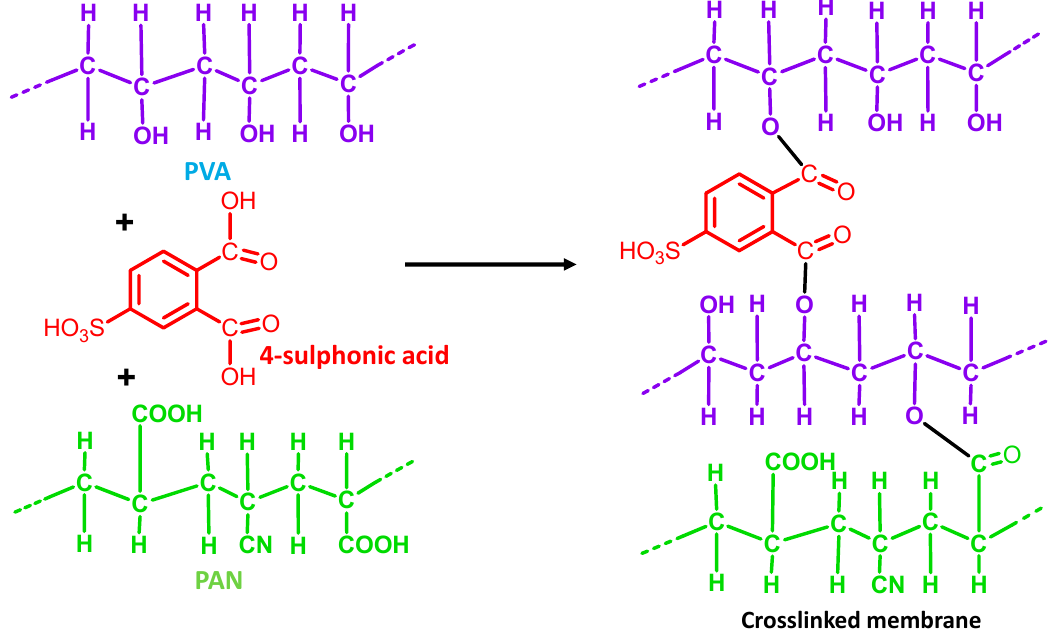
Figure 5. Crosslinking between alkali treated PAN and PVA by SPTA.